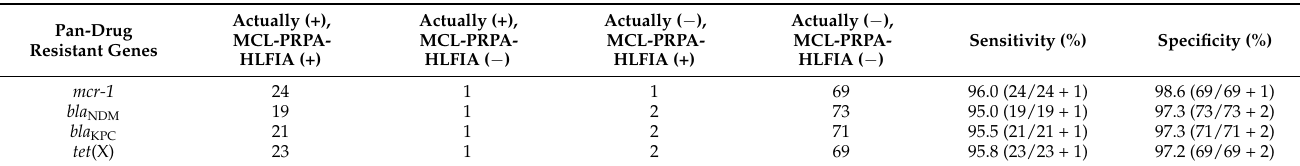
Table 1. Detection system sensitivity and specificity for detecting pan-drug-resistant genes in the simulated UTI sample.